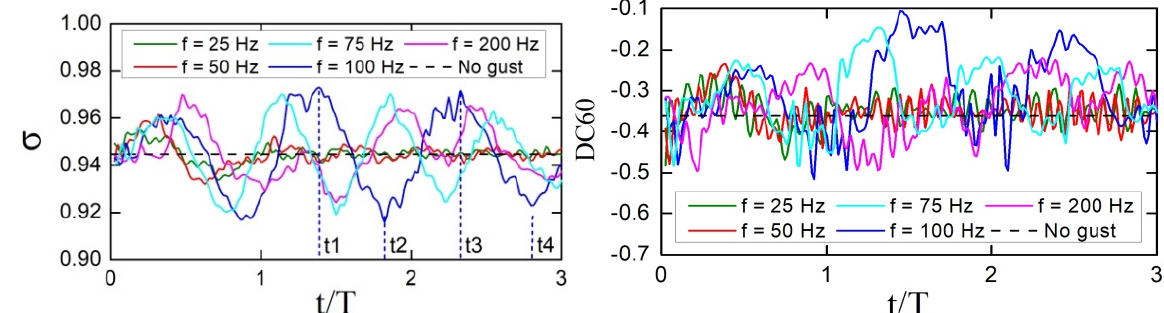
Figure 24. Time histories of the inlet performance at various gust frequencies combined with the amplitude of (cid:101) u g = 8 m/s.